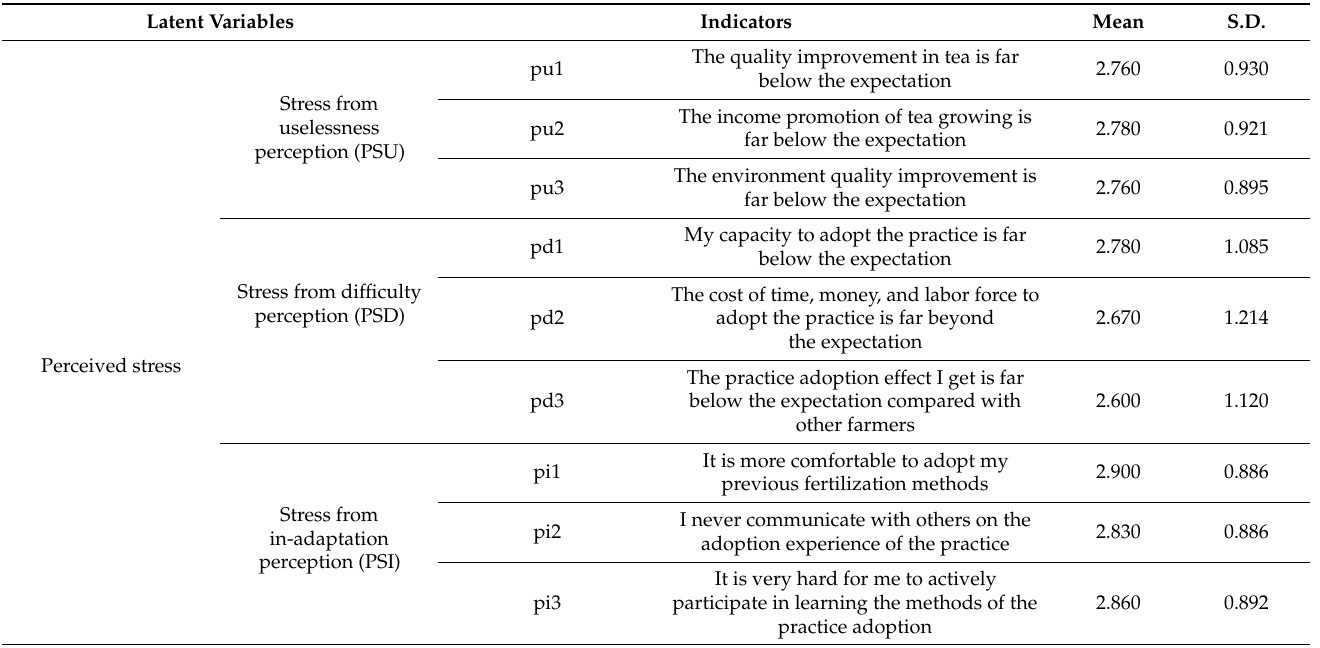
Table 1. Indicators for the latent